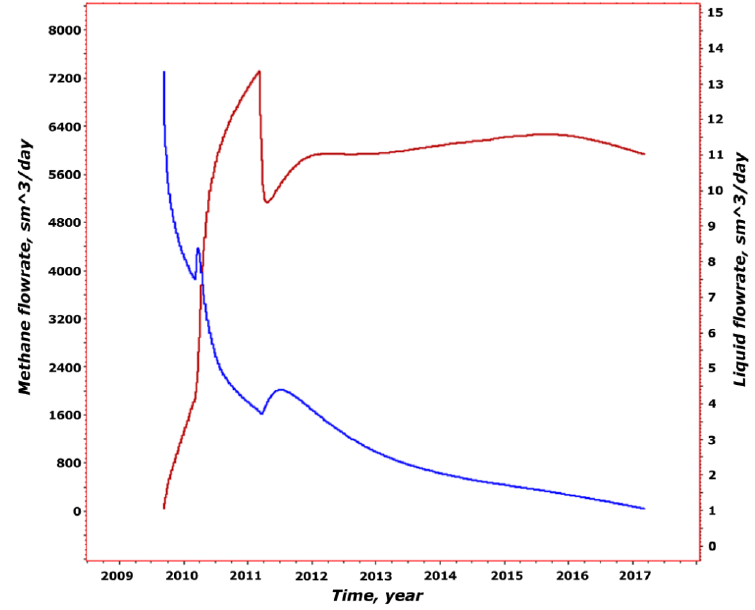
Figure 8. Daily production rates of water (blue line) and methane (red line).